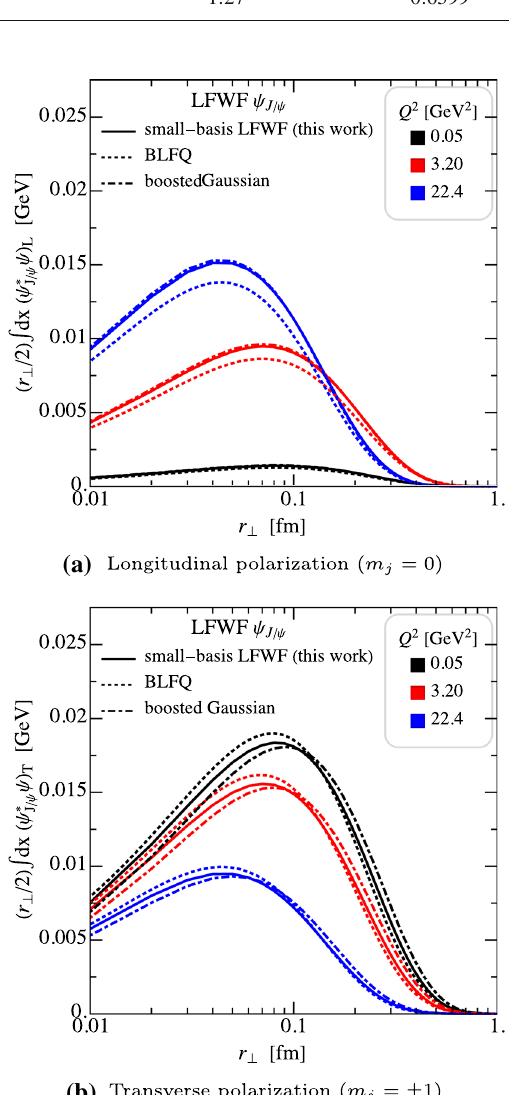
Fig. 13 The J /ψ -photon overlap functions [Eq. (72)] using three dif- ferent J /ψ LFWFs at Q 2 values representative of the data, for a the longitudinal polarization and b the transverse polarization. Solid lines are obtained using the small-basis LFWF (this work), dotted lines the BLFQ LFWF [26], and dot-dashed lines the boosted Gaussian LFWF [5]